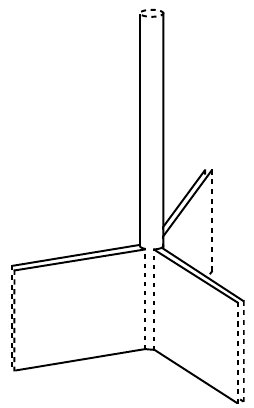
Figure 15 . In computing the cubic vertex evaluated on the solution, at an extreme limit of integration over wedge states one (cid:12)nds singular surfaces where (cid:13)ags are attached to an in(cid:12)nitely thin